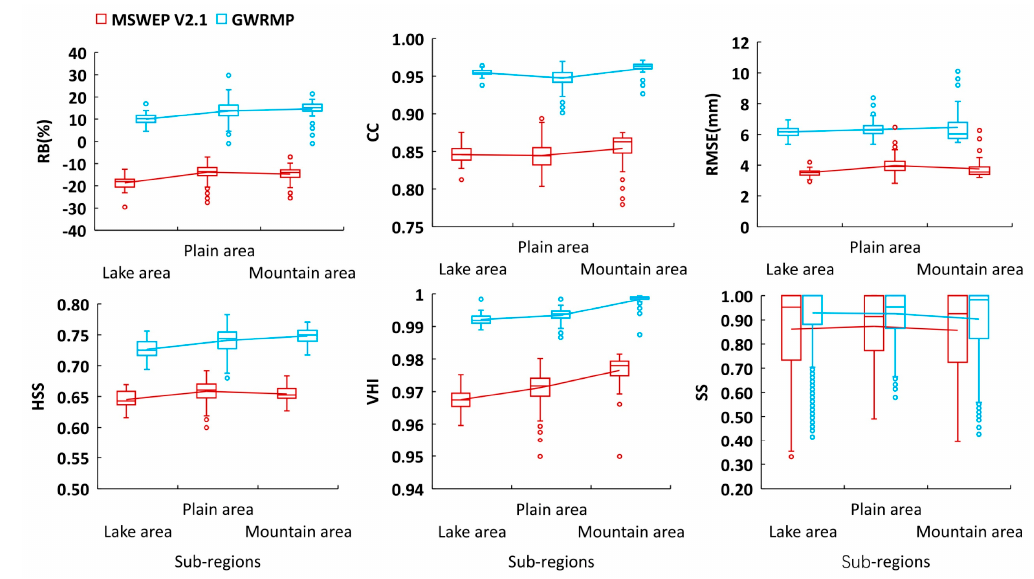
Figure 4. The box diagram of daily MSWEP V2.1, GWRMP accuracy at 0.1° × 0.1° grid scale.